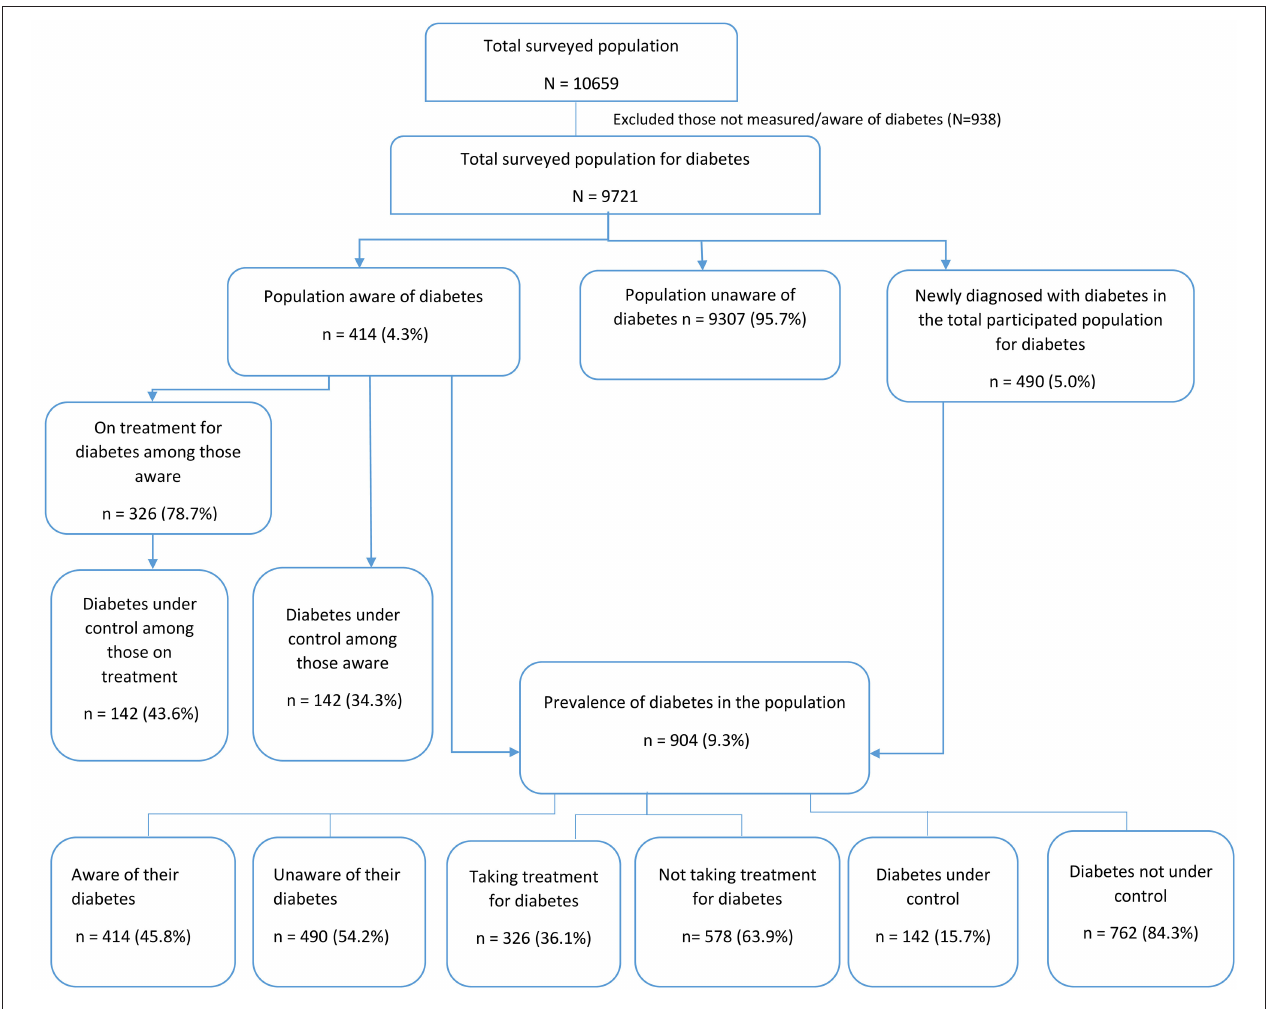
FIGURE 1 | Survey response rates of diabetes care cascade among adults (18–69 years) in